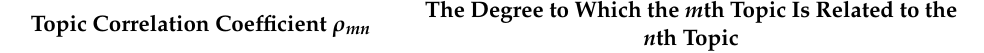
Table 3. The topic correlation coefficient ρ mn between topics of different